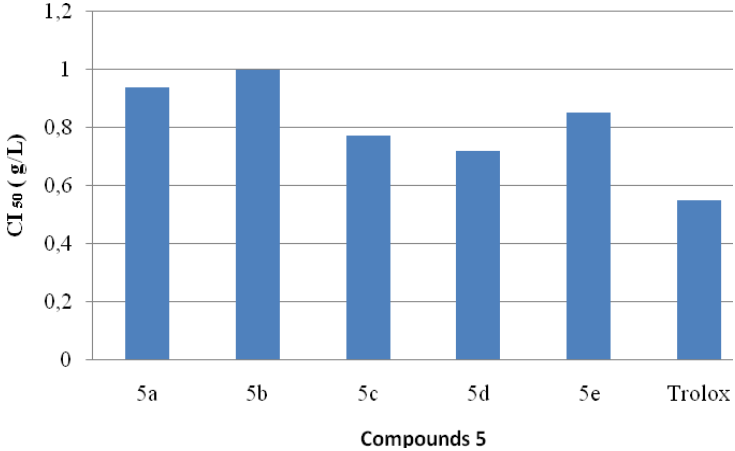
exhibited by coumarinic derivatives 5a – e 50